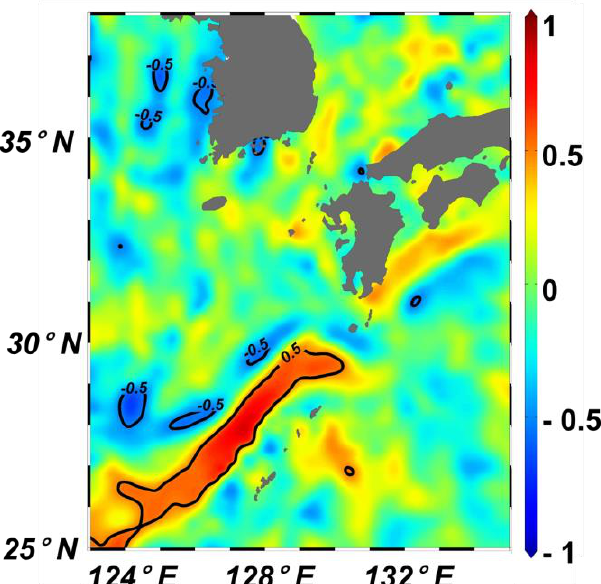
Figure 4. Horizontal distribution of the correlation coefficient between the geostrophic surface current velocity in January and the longitudinal shift of the Kuroshio Current Index in January. Black lines represent significant levels: p < 0.01.